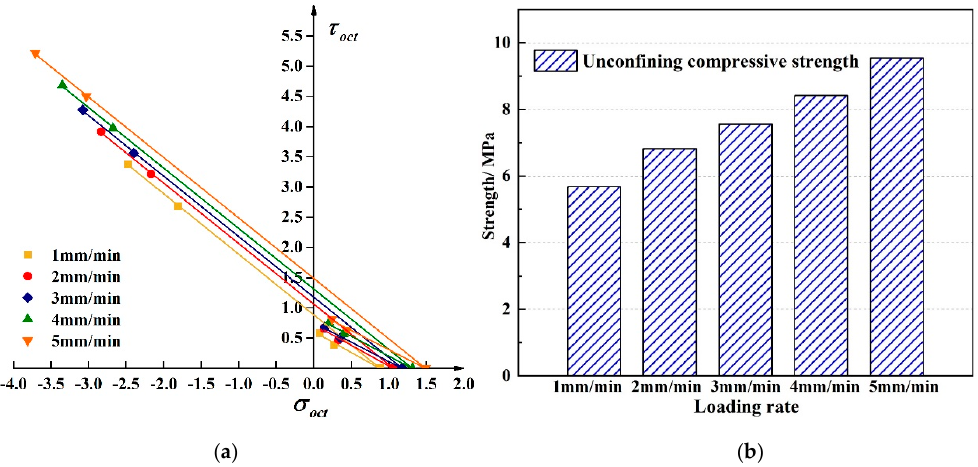
Figure 12. Linear compressive and tensile meridian under different loading rates. ( a ) The compressive